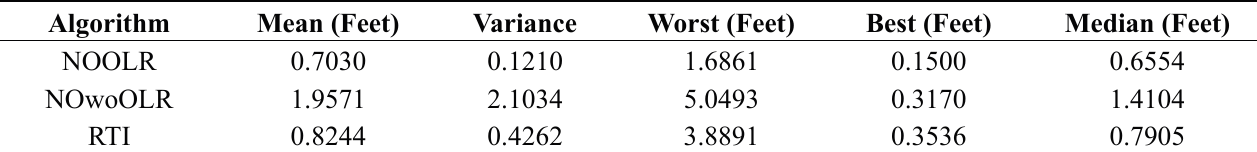
Table 5. Performance comparison of NOOLR , NOwoOLR, and